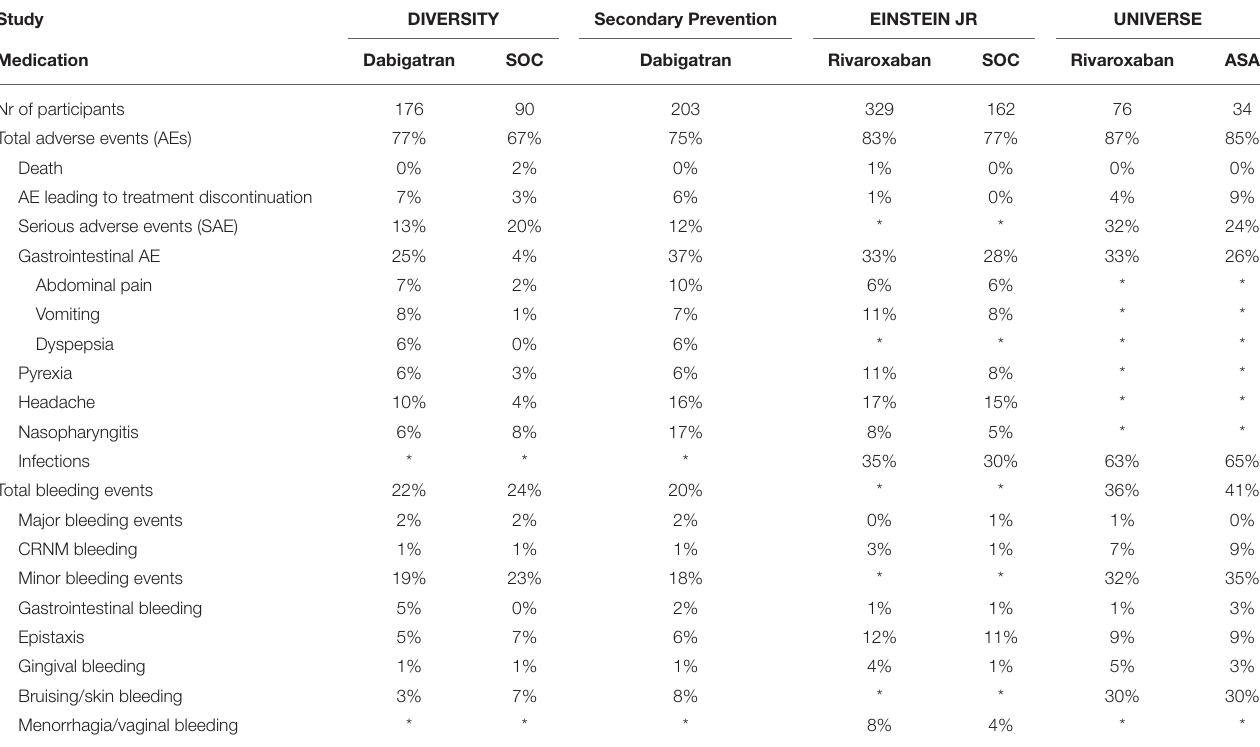
TABLE 1 | Comparison of adverse events and bleeding events in pediatric DOAC trials.